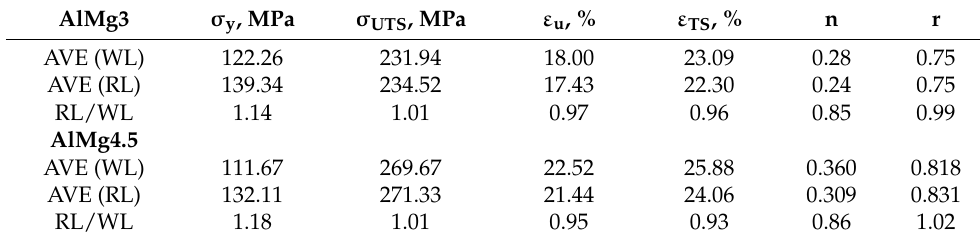
Table 3. Results of tensile tests—average values of all